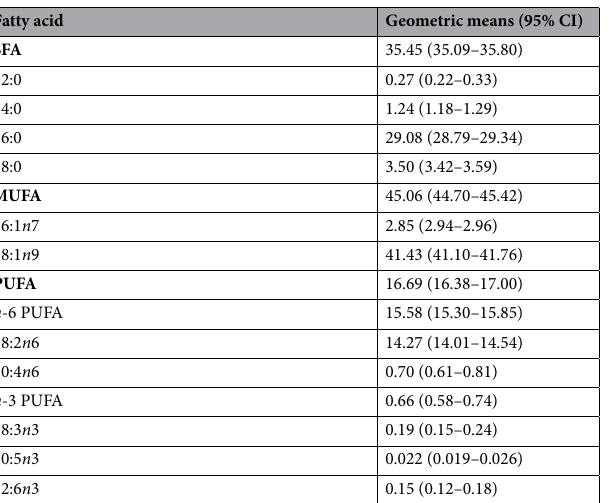
Table 2. Fatty acid composition of individual and classes of plasma triglyceride. Fatty acid values are percentage of total fatty acids and presented as geometric means (95% confidence interval). CI, confidence interval; MUFA, monounsaturated fatty acid; PUFA, polyunsaturated fatty acid; SFA, saturated fatty acid. Fatty acid nomenclature: 12:0 (lauric acid), 14:0 (myristic acid), 16:0 (palmitic acid), 16:1 n -7 (palmitoleic acid), 18:0